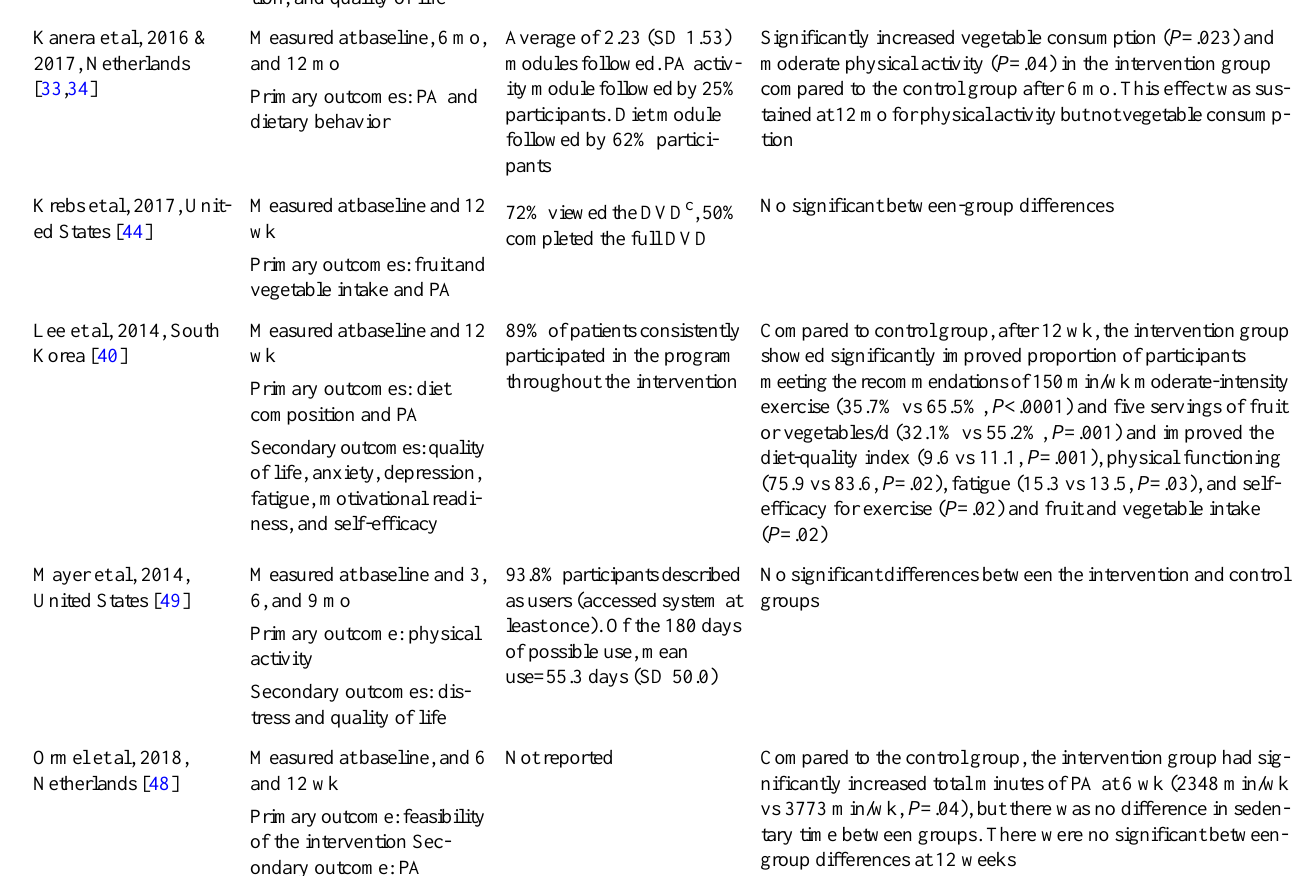
Between-group findingsIntervention uptakeOutcomesAuthor, year, country Compared to control group, the intervention group showed